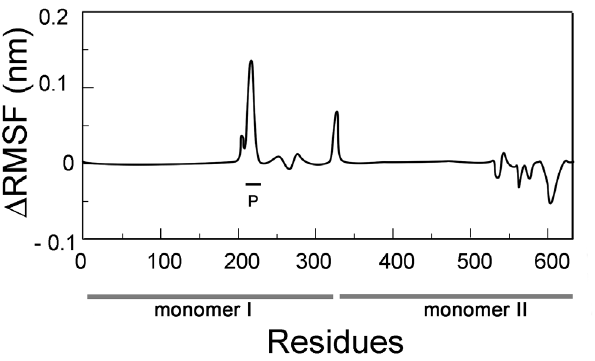
Figure 8. Effect of adenine nucleotide binding on PaNTD dimers. SBM simulations of PaNTD dimers bound to ATP or ADP were performed and the average fluctuation per residue (RMSF) was obtained. RMSF difference ( D RMSF) between ADP and ATP bound dimers is shown. Monomer A: r. 1–329; monomer B: r. 330–658. P: Putative interaction site.